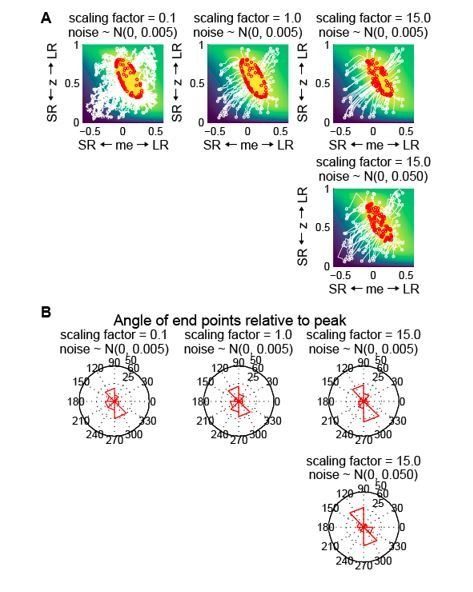
Gradient updating with randomness in the starting location and each updating step does not generate the biased end-point pattern seen in the data.(A) Simulation of reward-gradient updating trajectories starting from random locations (white circles) on the reward function. Each updating step = scaling factor x gradient + noise (noise along the me and z dimensions were generated independently from the same Gaussian distribution). The updating process stopped when reward exceeded 97% of the maximum (red circles indicate end points). Note that the end-points of the updating process were located all around the reward-function plateau. The reward function was from the LR-R blocks in an example session of monkey C. (B) Polar histograms of the angle of the end-points relative to the peak of the reward function, showing end-points scattered all around the peak with clusters in two locations.